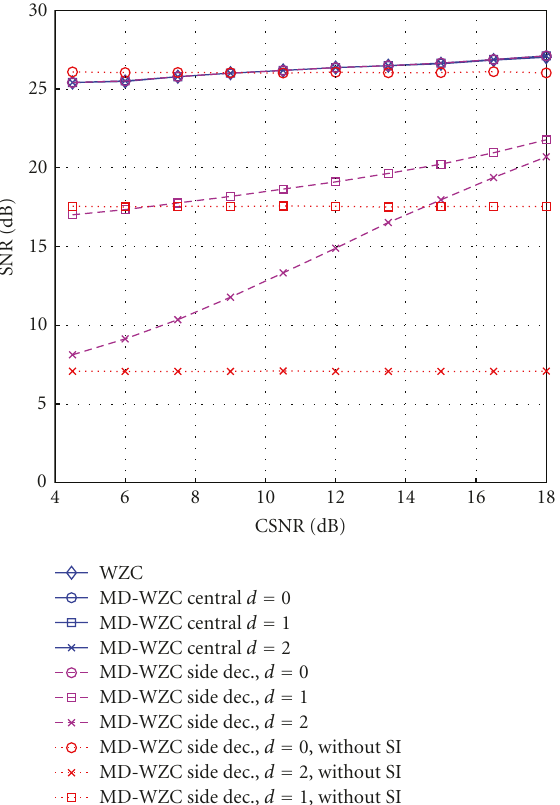
the nonoptimality of the MDSQ does not deflect from the central focus of this paper.